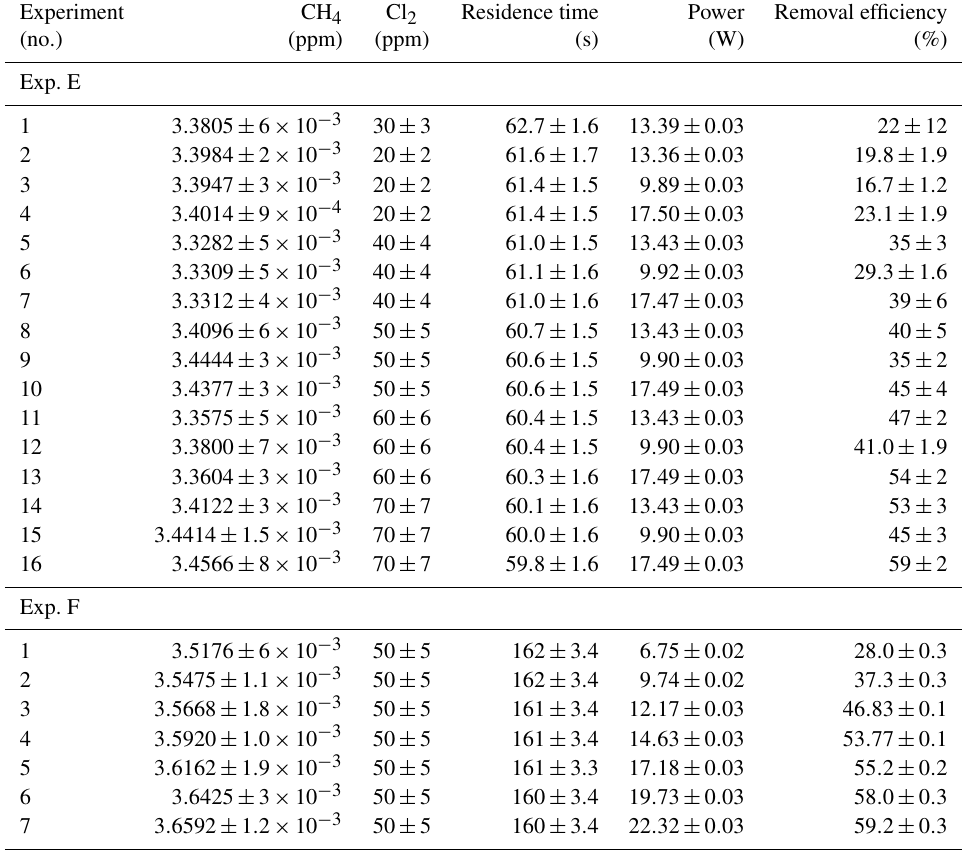
Table D2. Data for exp. E–F. Columns: experimental steps, [CH 4 ] (ppm), [Cl 2 ] (ppm), residence time t R (s), power input p IN (W) and the resulting removal efficiency in